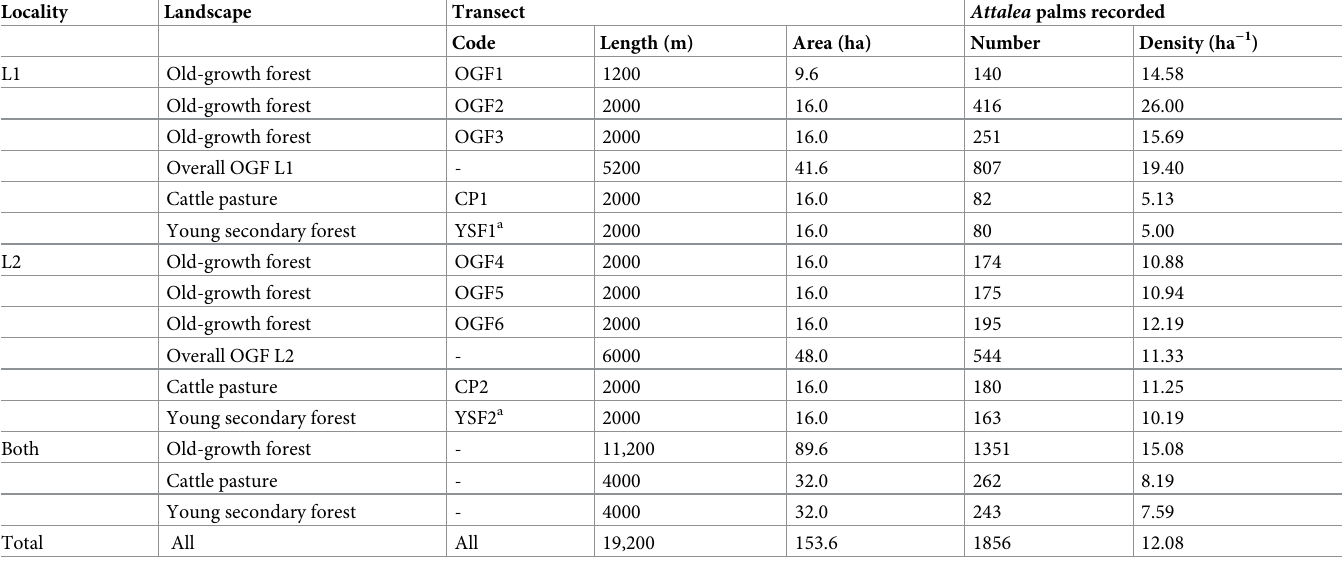
a Visual inspection of Landsat satellite imagery (https://earthexplorer.usgs.gov/) suggested that, at the time of sampling, secondary forest had been growing for ~4–5 y in L1 and for ~7–10 y in